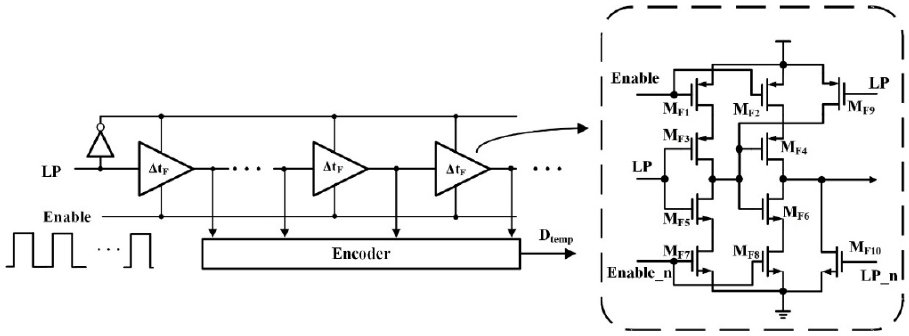
Figure 12. Structure of the